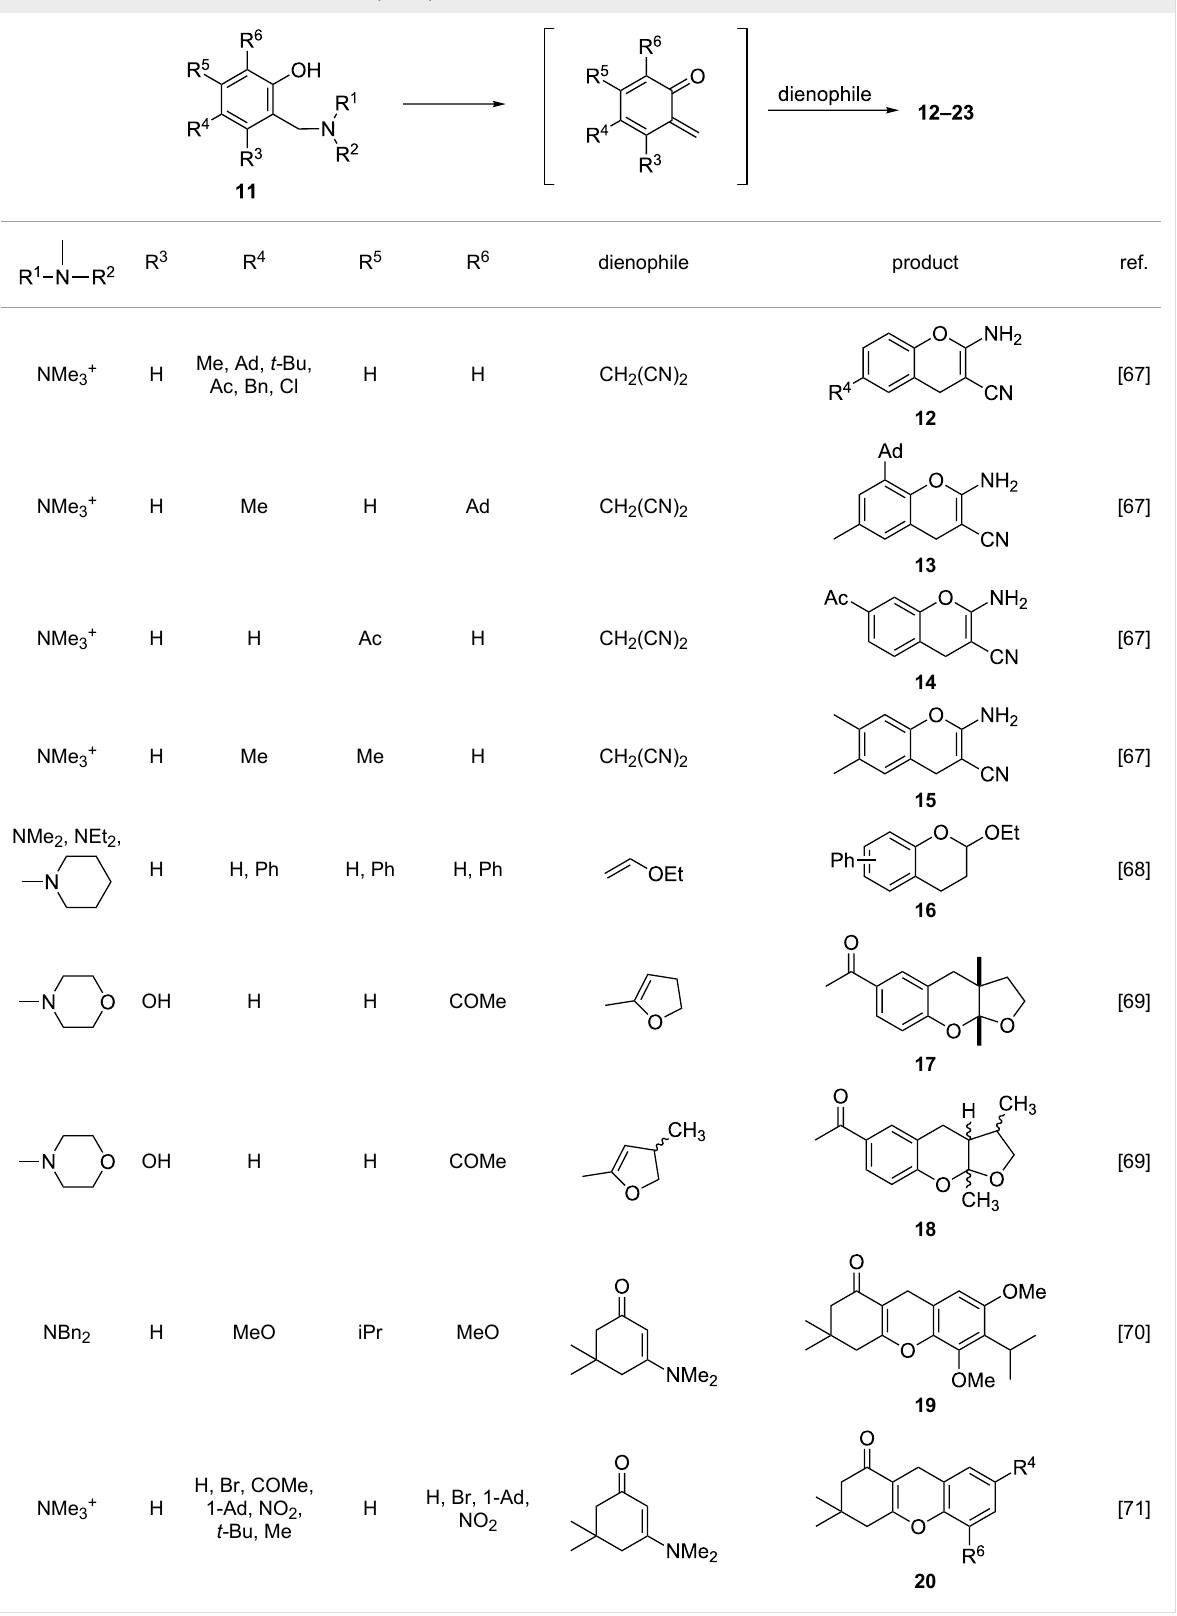
R 3 R 4 R 5 R 6 dienophile product